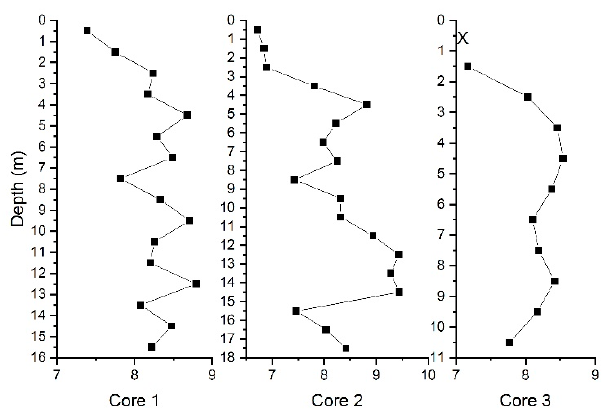
Figure 6. Vertical distribution of pH in core samples.